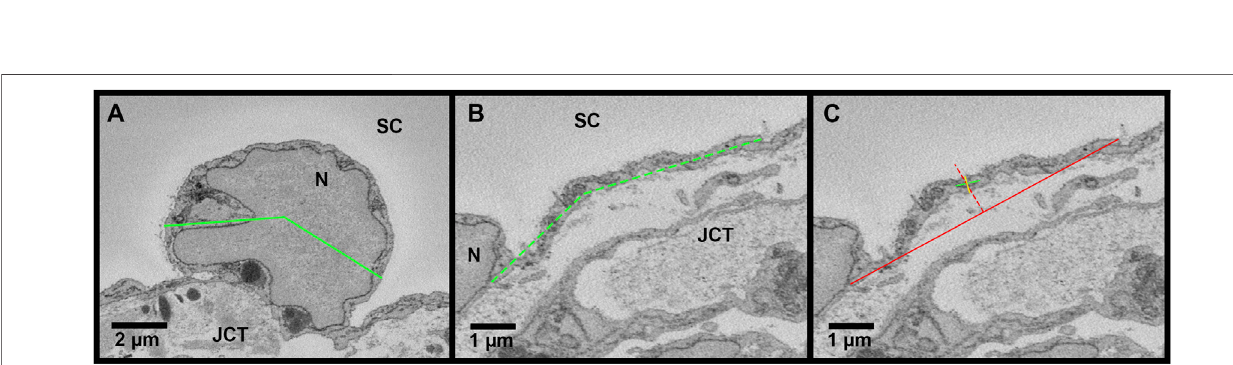
Frontiers in Cell and Developmental Biology |